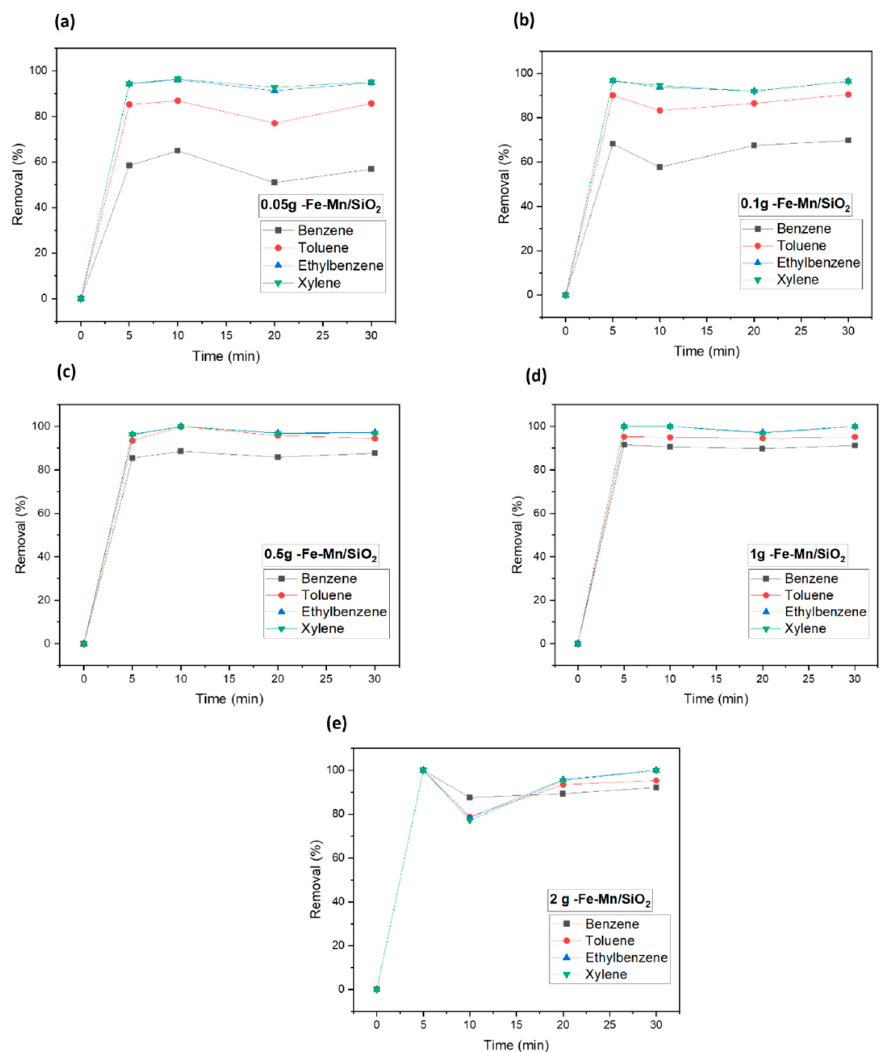
Figure 6. Catalyst dosage experiment for Fe-Mn/SiO 2 (Fe 2 O 3 -Mn 2 O 3 /SiO 2 ) of nanocomposites.